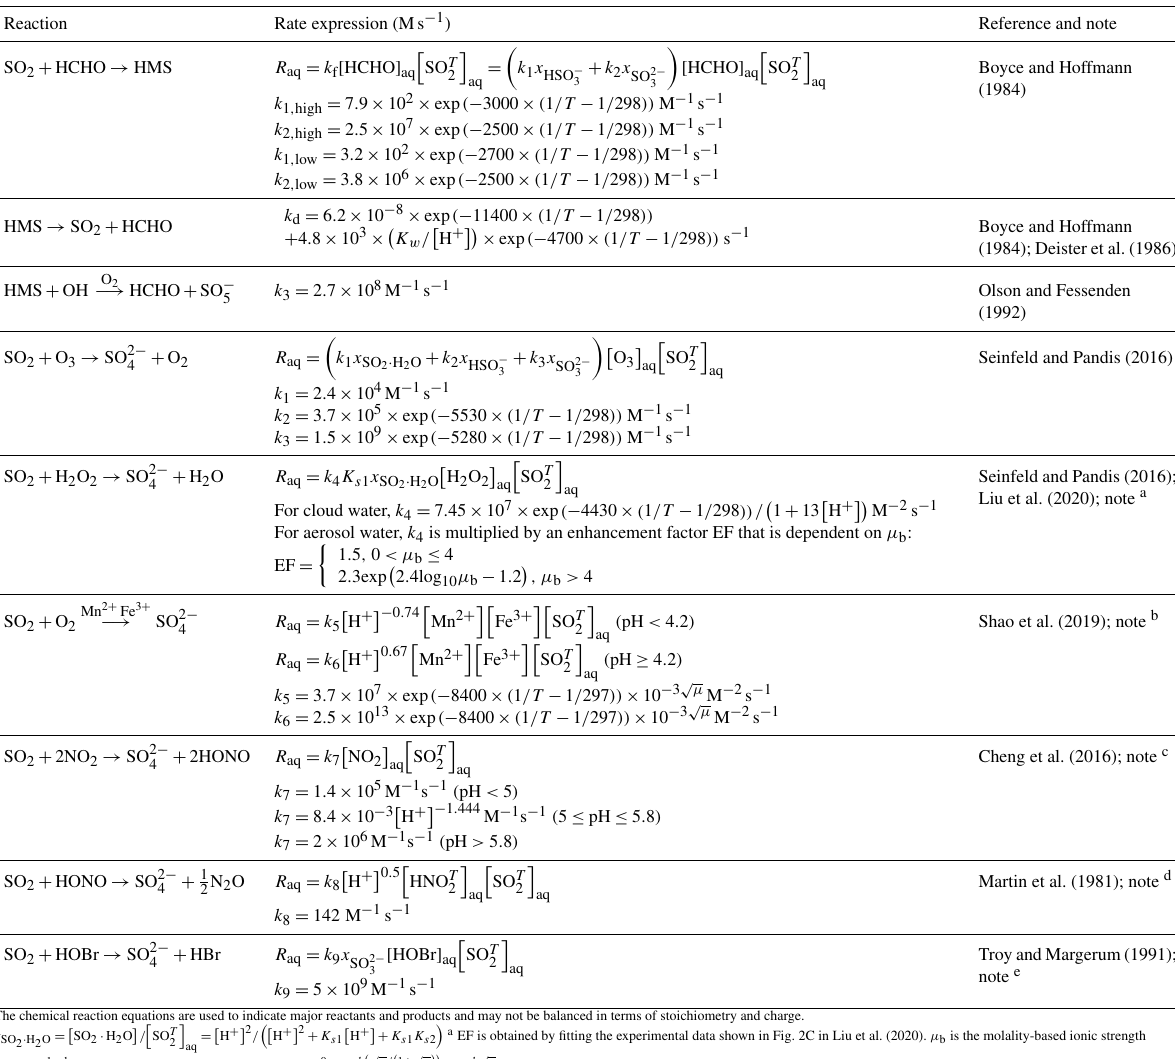
Table 1. Aqueous-phase reaction rate expressions. Reaction Rate expression (Ms − 1